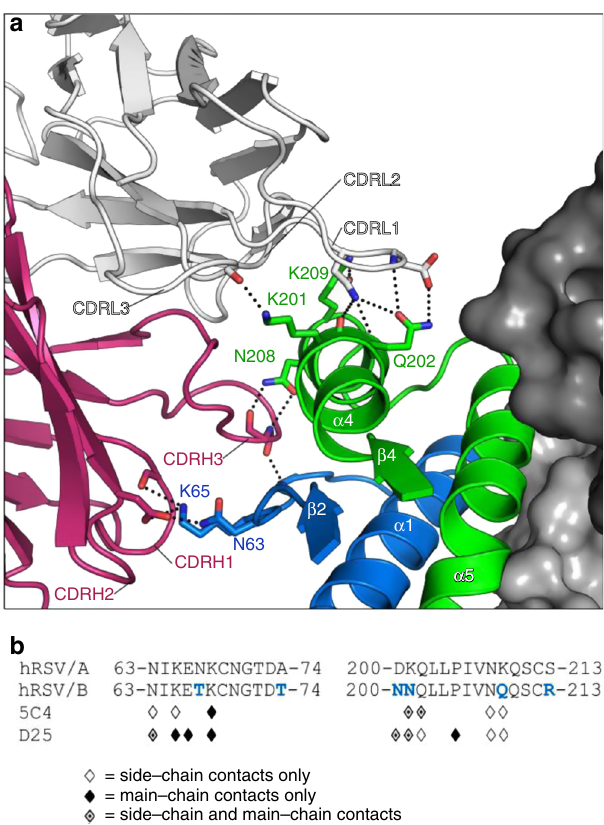
contacts= main–chain contacts only = side–chain and main–chain Fig. 3 5C4 forms few hydrogen bonds to RSV F main-chain atoms. a Two pre-F protomers are shown as dark and light gray surfaces, and the third protomer is shown as ribbons with F1 colored green and F2 colored blue. 5C4 heavy and light chains are shown as ribbons with the heavy and light chains colored pink and white, respectively. Antibody complementarity- determining regions (CDRs) involved in molecular recognition are labeled. Main-chain and side-chain atoms involved in molecular recognition are shown in stick representation with oxygen atoms colored red and nitrogen atoms colored blue. Hydrogen bonds and salt bridges are depicted as black dotted lines. b Linear sequence of antigenic site Ø for both RSV subtypes with the F2 β 2 – α 1 loop on the left and the F1 α 4 helix on the right. Subtype- speci fi c residues in site Ø are colored blue in the subtype B consensus sequence. RSV F residues that make hydrogen bonds to 5C4 and D25 are denoted with symbols (side-chain hydrogen bonds, main-chain hydrogen bonds, or side-chain and main-chain hydrogen bonds are represented as open, fi lled, or partially fi lled diamonds, Antigenic determinants of 5C4 subtype speci fi city . To test our amino acid substitution at RSV F position 201, we quanti fi ed 5C4 binding to a panel of single amino acid F variants for each of the fi ve subtype-dependent residues in site Ø, as well as for two